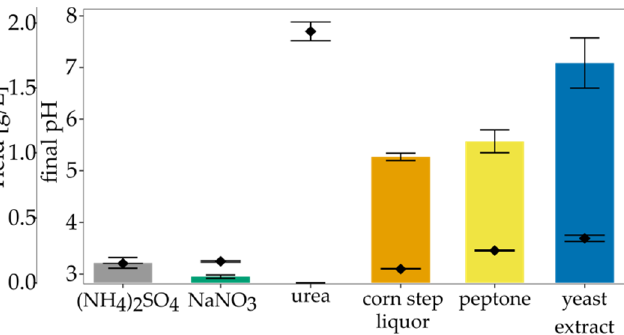
Figure 5. The yield of BNC and final pH in media modified with different nitrogen sources. Bars represent yield and points pH. Error bars represent standard deviation.